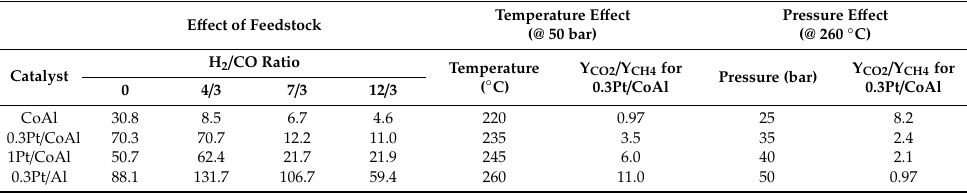
Table 4. Y CO2 / Y CH4 yields ratio for all the